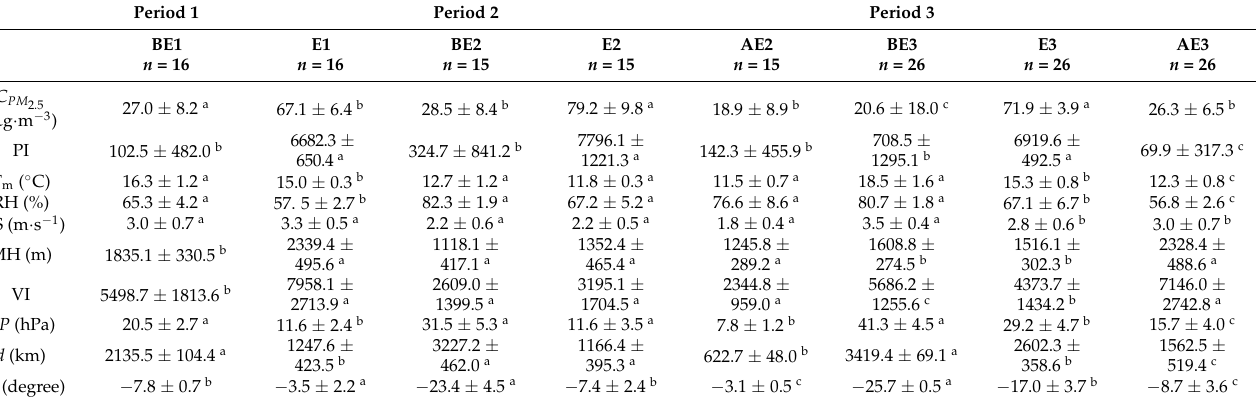
Table 4. Mean PM 2.5 concentrations ( C PM ) and major parameters in winter from 2015 to 2020 2.5 during the three periods including events 1, 2, and 3 in the Taipei